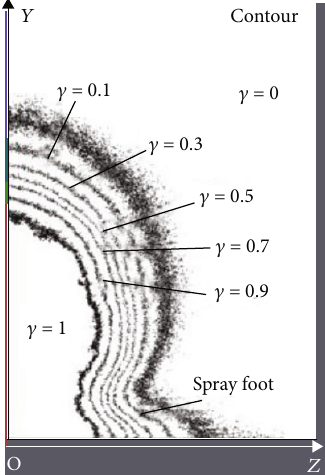
Figure 11: Schematic diagram of Wu ’ s empirical